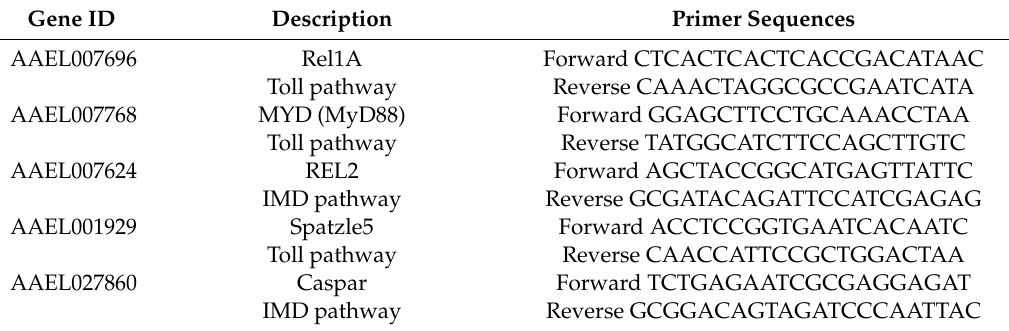
Table 1. Primer sequences for testing immune response related gene expressions.